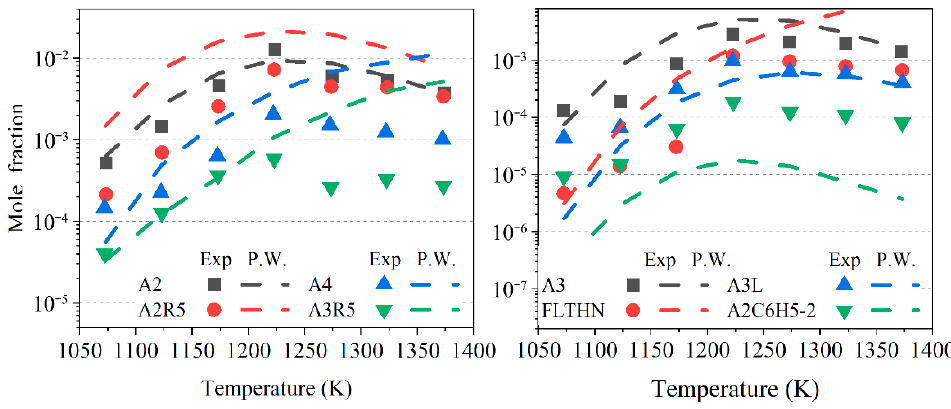
Figure 6. Numerical simulation of the prediction results of acetylene pyrolysis species concentrations (heavy molecules) and data with experimental results. P.W.—present work. Exp—Norinaga et al. [37].